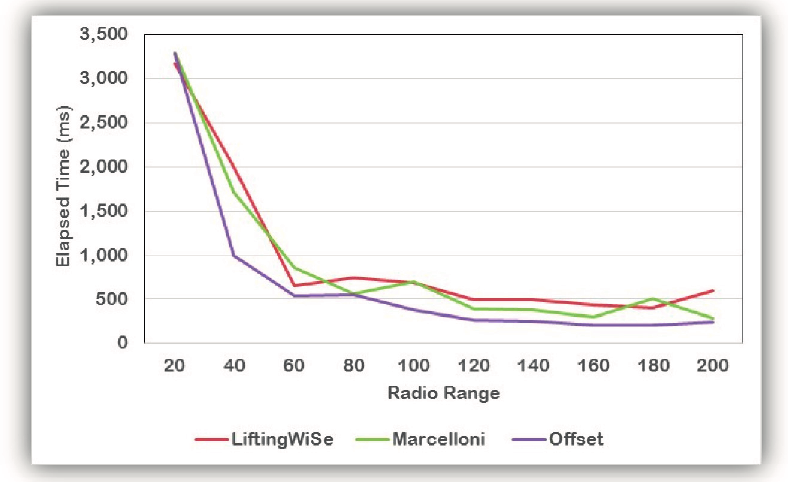
Figure 12. The effect of the radio range on the execution time.